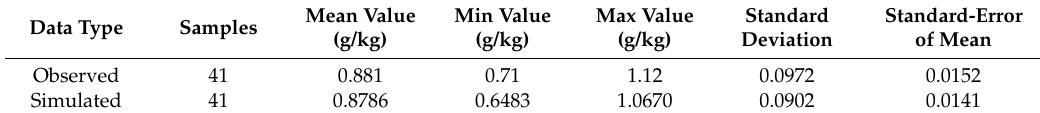
Table 4. Statistical analysis of the observed value and the simulated value.